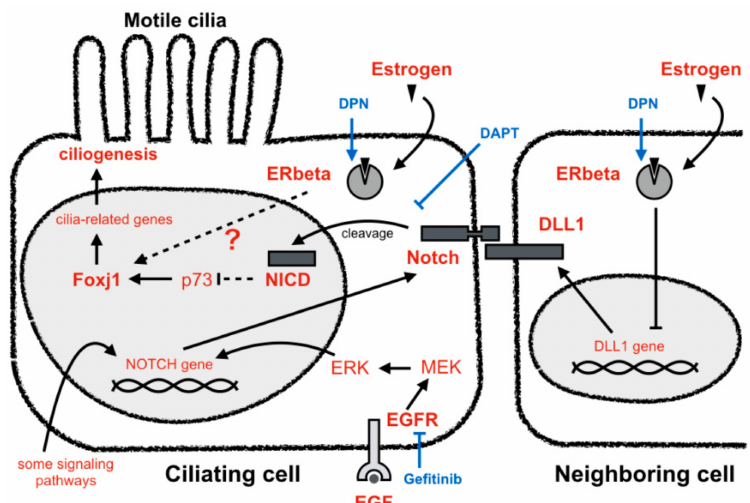
Figure 6. Molecular interplay between estrogen, EGF, and Notch signaling pathways in FTEC ciliogenesis. This schematic view illustrates the role of estrogen in multiple ciliogenesis of motile cilia. First, the activation of ER β by estrogen suppresses DLL1 , leading to the downregulation of Notch signaling in ciliating cells. FOXJ1 is a master regulator of multiple ciliogenesis, which is indirectly inhibited by Notch pathway. Therefore, inhibition of Notch pathway by estrogen facilitates the ciliogenesis of motile cilia. While there is no definitive evidence in this study, the possibility still exists that ER β directly induces FOXJ1 . Second, EGFR-MEK-ERK pathway stimulate Notch signal to maintain a proliferative state or induce di ff erentiation into other cell types. Treatments with gefitinib or DAPT respectively suppress EGF and NOTCH pathway, and consequently induce ciliogenesis. There are several other pathways acting on the NOTCH gene. Ciliogenesis is established on the balance